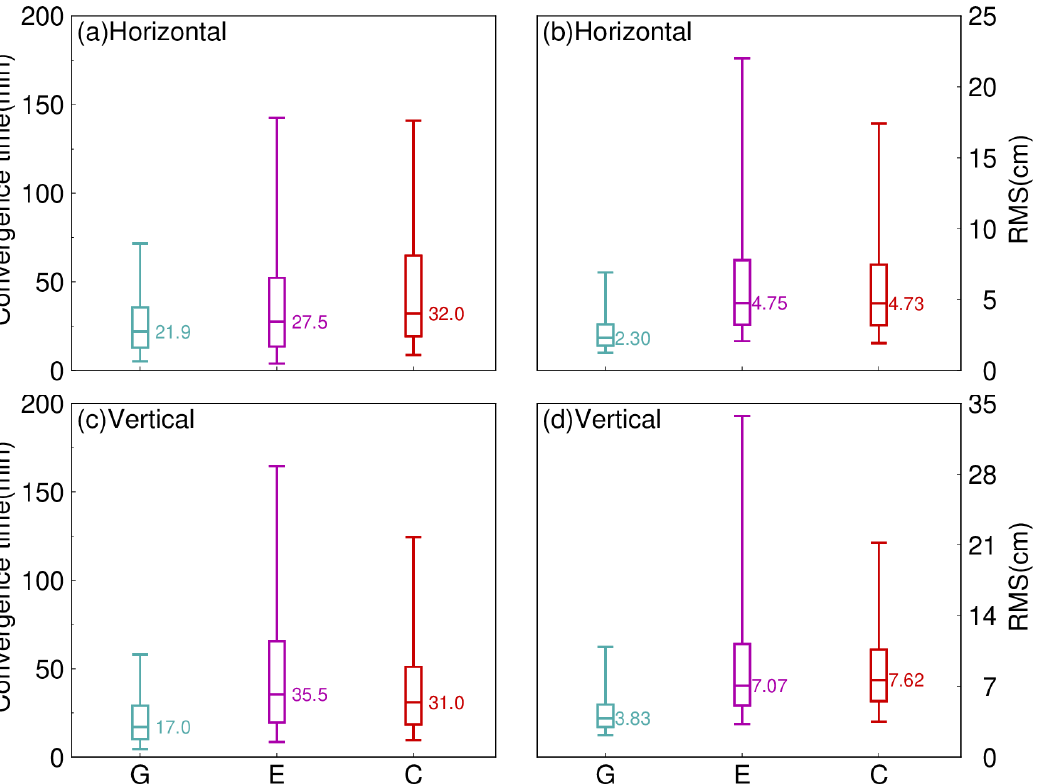
Figure 6. Distribution of the convergence time and RMS of kinematic PPP solutions in three single systems (G is short for GPS, E is short for Galileo, and C is short for BDS-3) in September 2022. ( a ) Horizontal component of convergence time, ( b ) Horizontal component of RMS, ( c ) Vertical component of convergence time, ( d ) Vertical component of RMS.